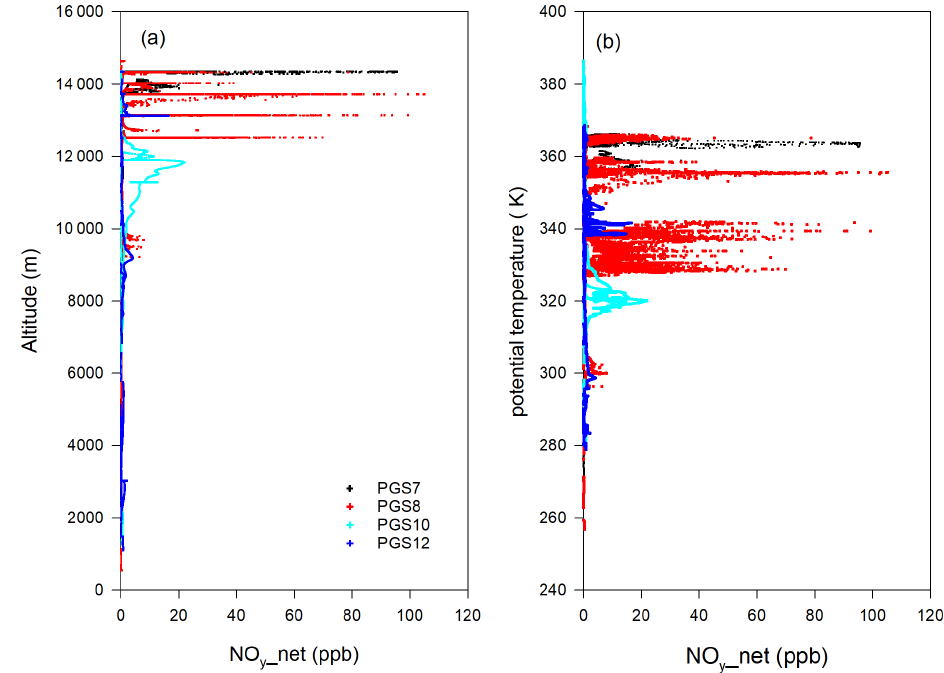
Figure 12. NO y _net versus altitude (a) and NO y _net versus potential temperature (b) for all flights with the occurrence of particulate nitrate (18, 20, 25, 31 January